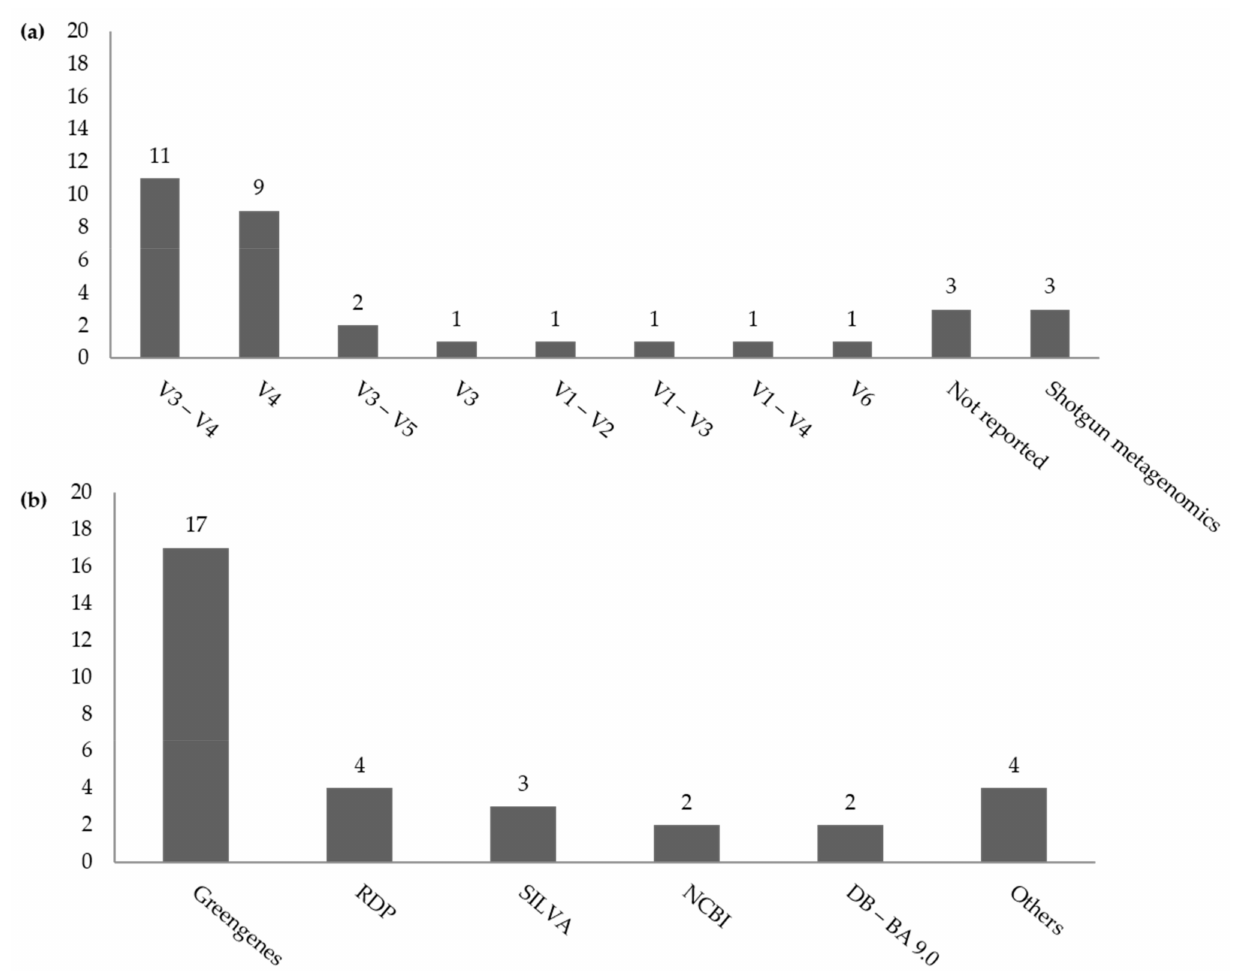
Figure 2. SrRNA, by amplified region, or Shotgun metagenomics; ( b ) reference databases used for taxonomic classification reported in 32 studies. Note that some studies amplified multiple regions or used multiple